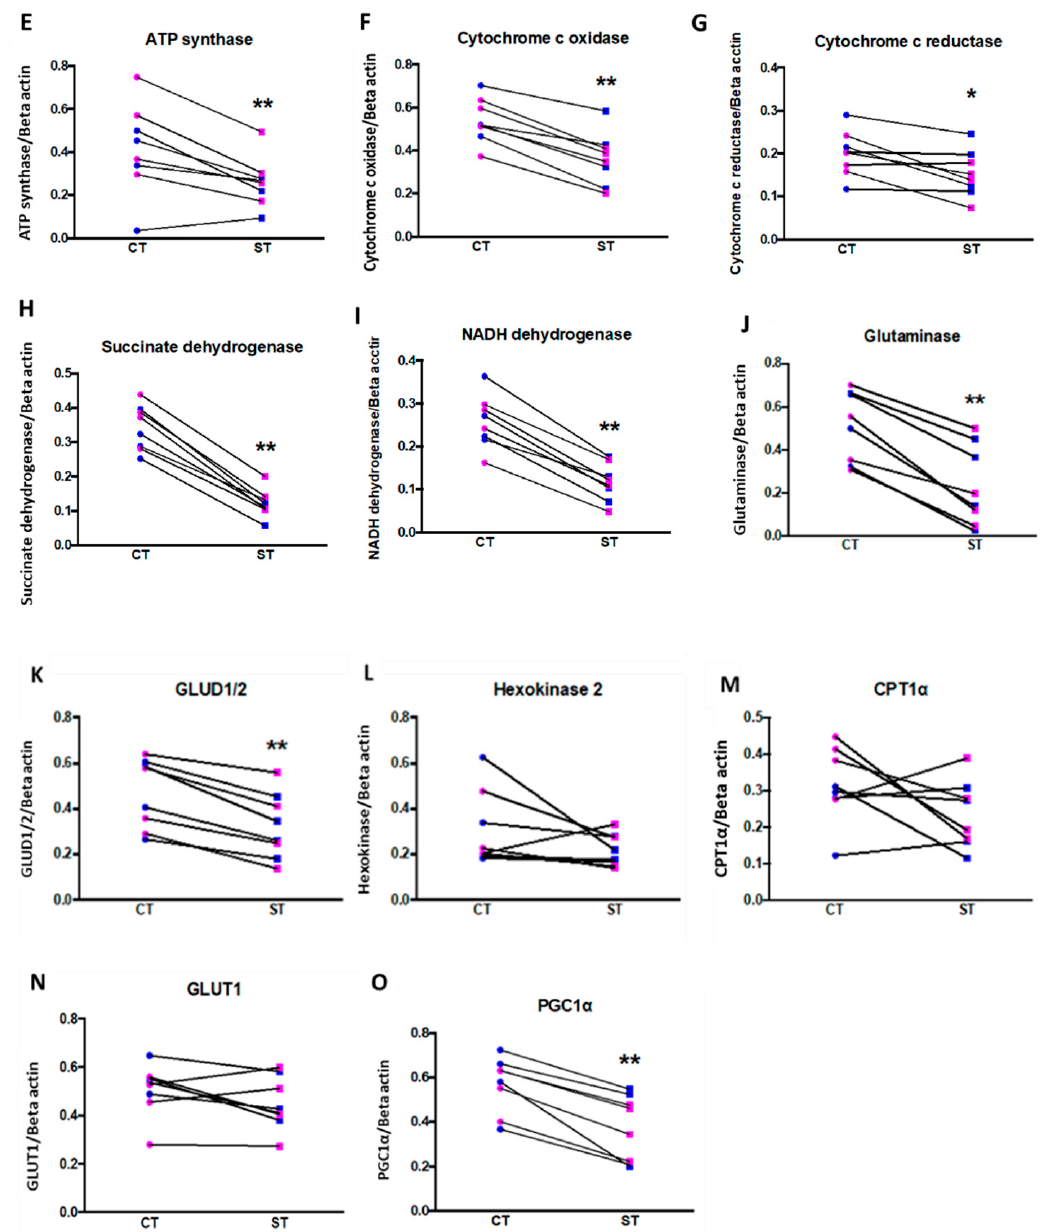
Figure 7. Effect of trophoblast differentiation on specific mitochondrial protein expression. Representative western blots ( A – D ) and quantification ( E – O ) of cellular proteins in CT vs. ST. Data plotted as individual values of paired CT and ST from the same sample Male (blue, n = 4) and female (pink, n = 4) fetal sex groups combined. * p < 0.05, ** p < 0.01, (Wilcoxon test, CT vs. ST).